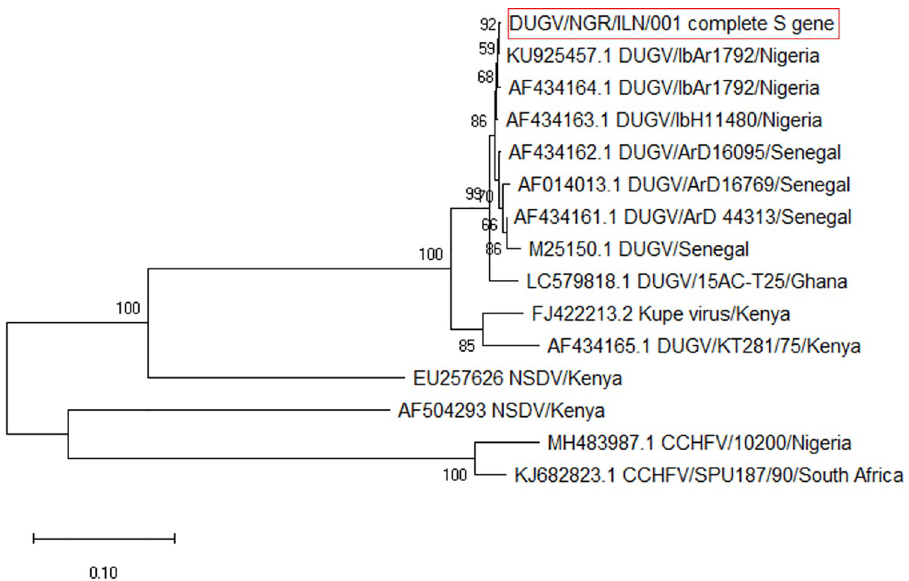
Fig 3. Phylogenetic relationship among DUGV strain recovered in this study and reference strains based on nucleotide sequence of a 1,673 bp fragment of the S segment gene.